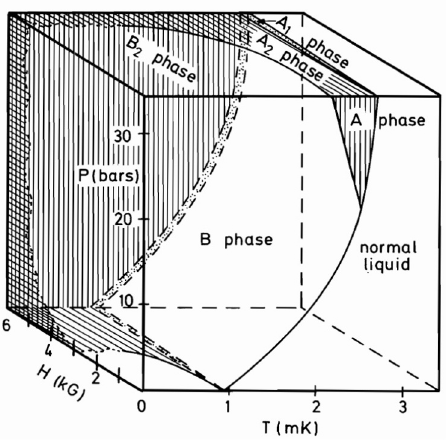
Figure 1 . P(ressure)-T(emperature)-H(magnetic field intensity) phase diagram of Helium-3. Although the p+ip order is isotropic in x-y plane, it breaks the chiral symmetry.